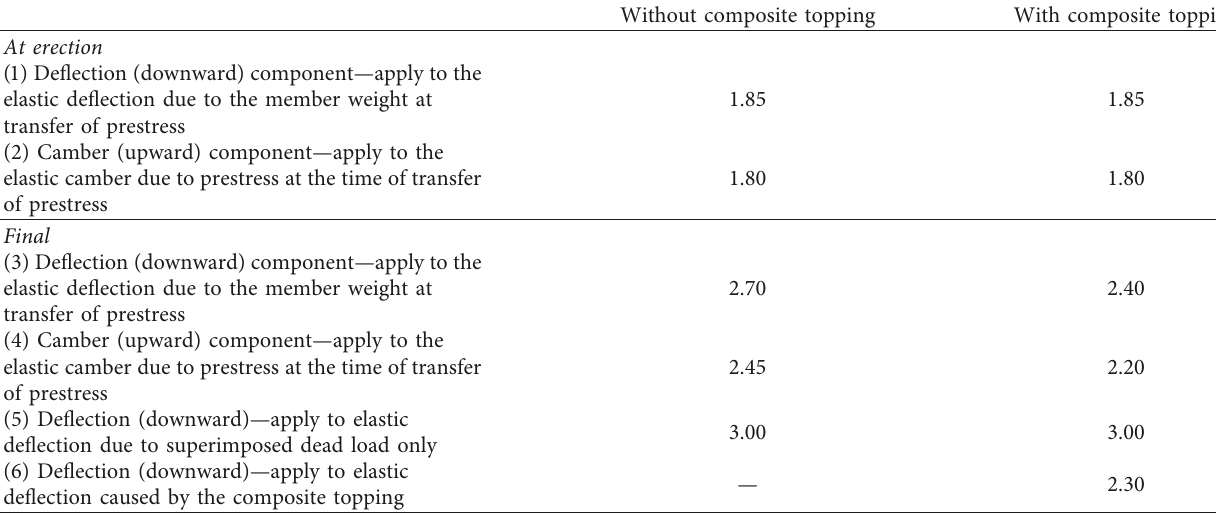
Table 1: PCI Bridge Design Manual basic multipliers [18]. Without composite